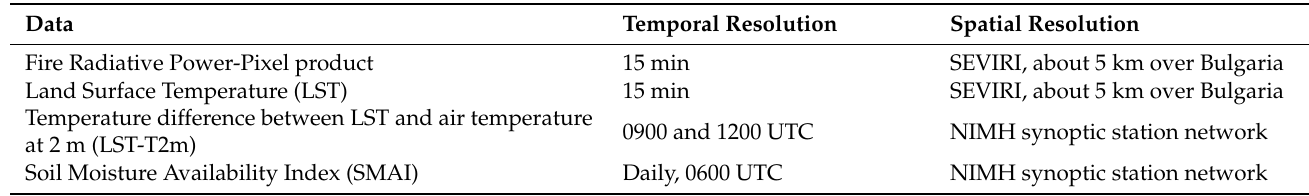
Table 1. Summary of data used and their